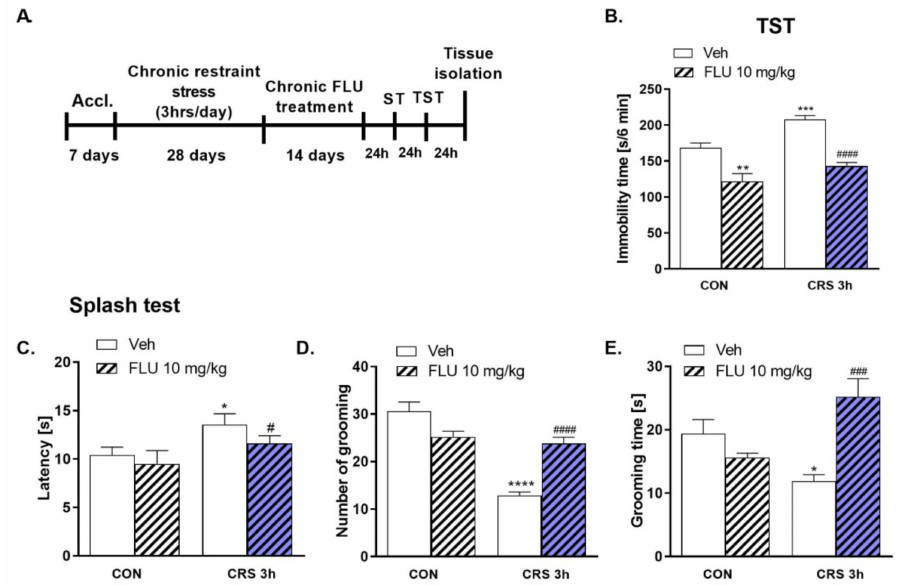
Figure 2. The effect of fluoxetine treatment on CRS-induced behavioral changes. ( A ) Experimental schedule; ( B ) Effects of CRS and FLU in the TST; ( C – E ) Effects of CRS and FLU in the ST in mice. All data were analyzed by two-way ANOVA and Newman–Keuls multiple comparison test. Values are expressed as mean ± SEM; n = 8–9. * p < 0.05, ** p < 0.01, *** p < 0.001, **** p < 0.0001 vs. CON, # p < 0.05, #### p < 0.0001 vs. CRS. CON—control group; CRS-chronic restraint stress; Accl.—an acclimation